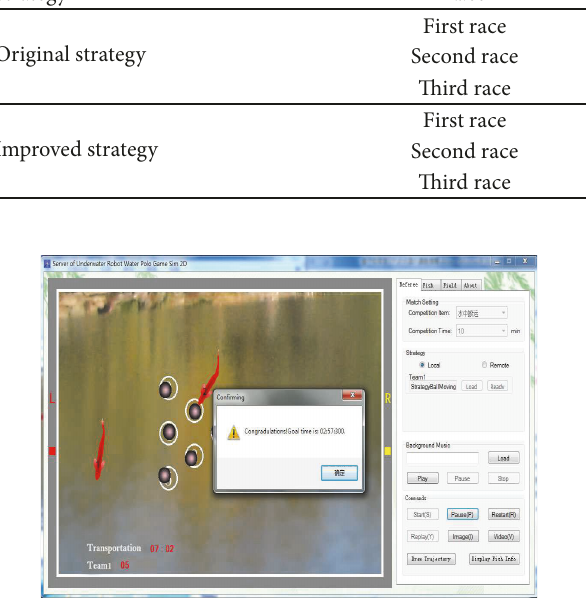
Figure 8: The completion of the game by the proposed